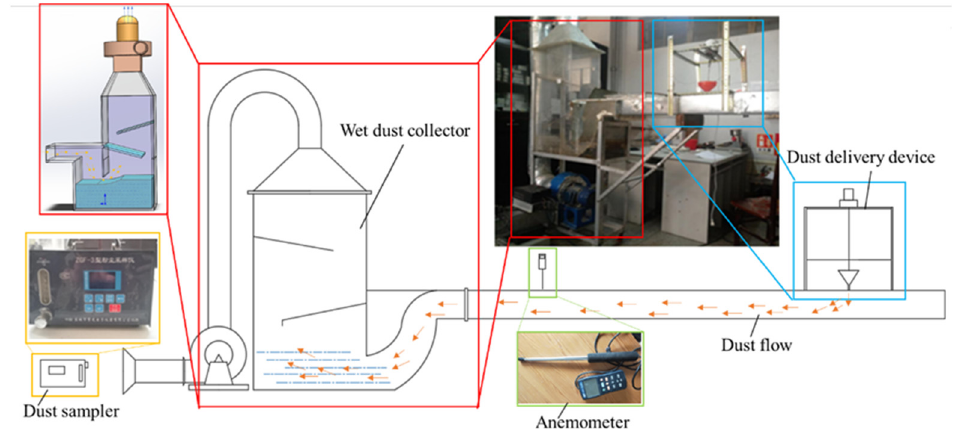
Figure 1. Experimental system.